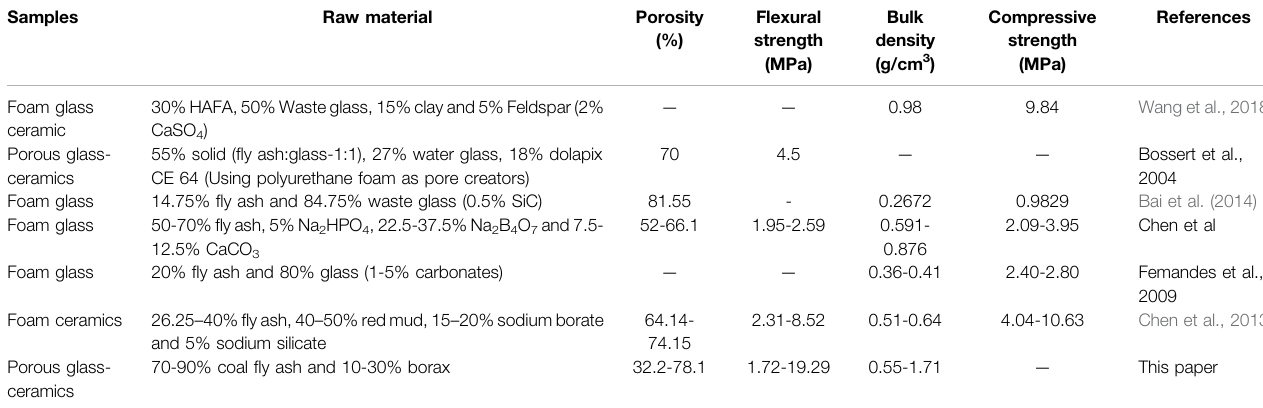
TABLE 2 | Comparison of properties of porous materials prepared from coal fl y ash.